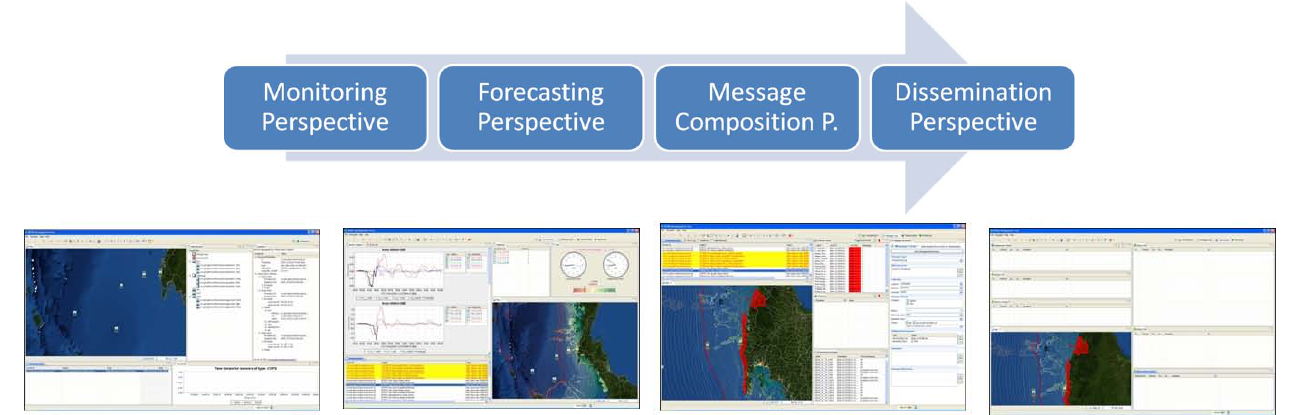
Fig. 5. Perspectives guide operators in comprehensive workflow.